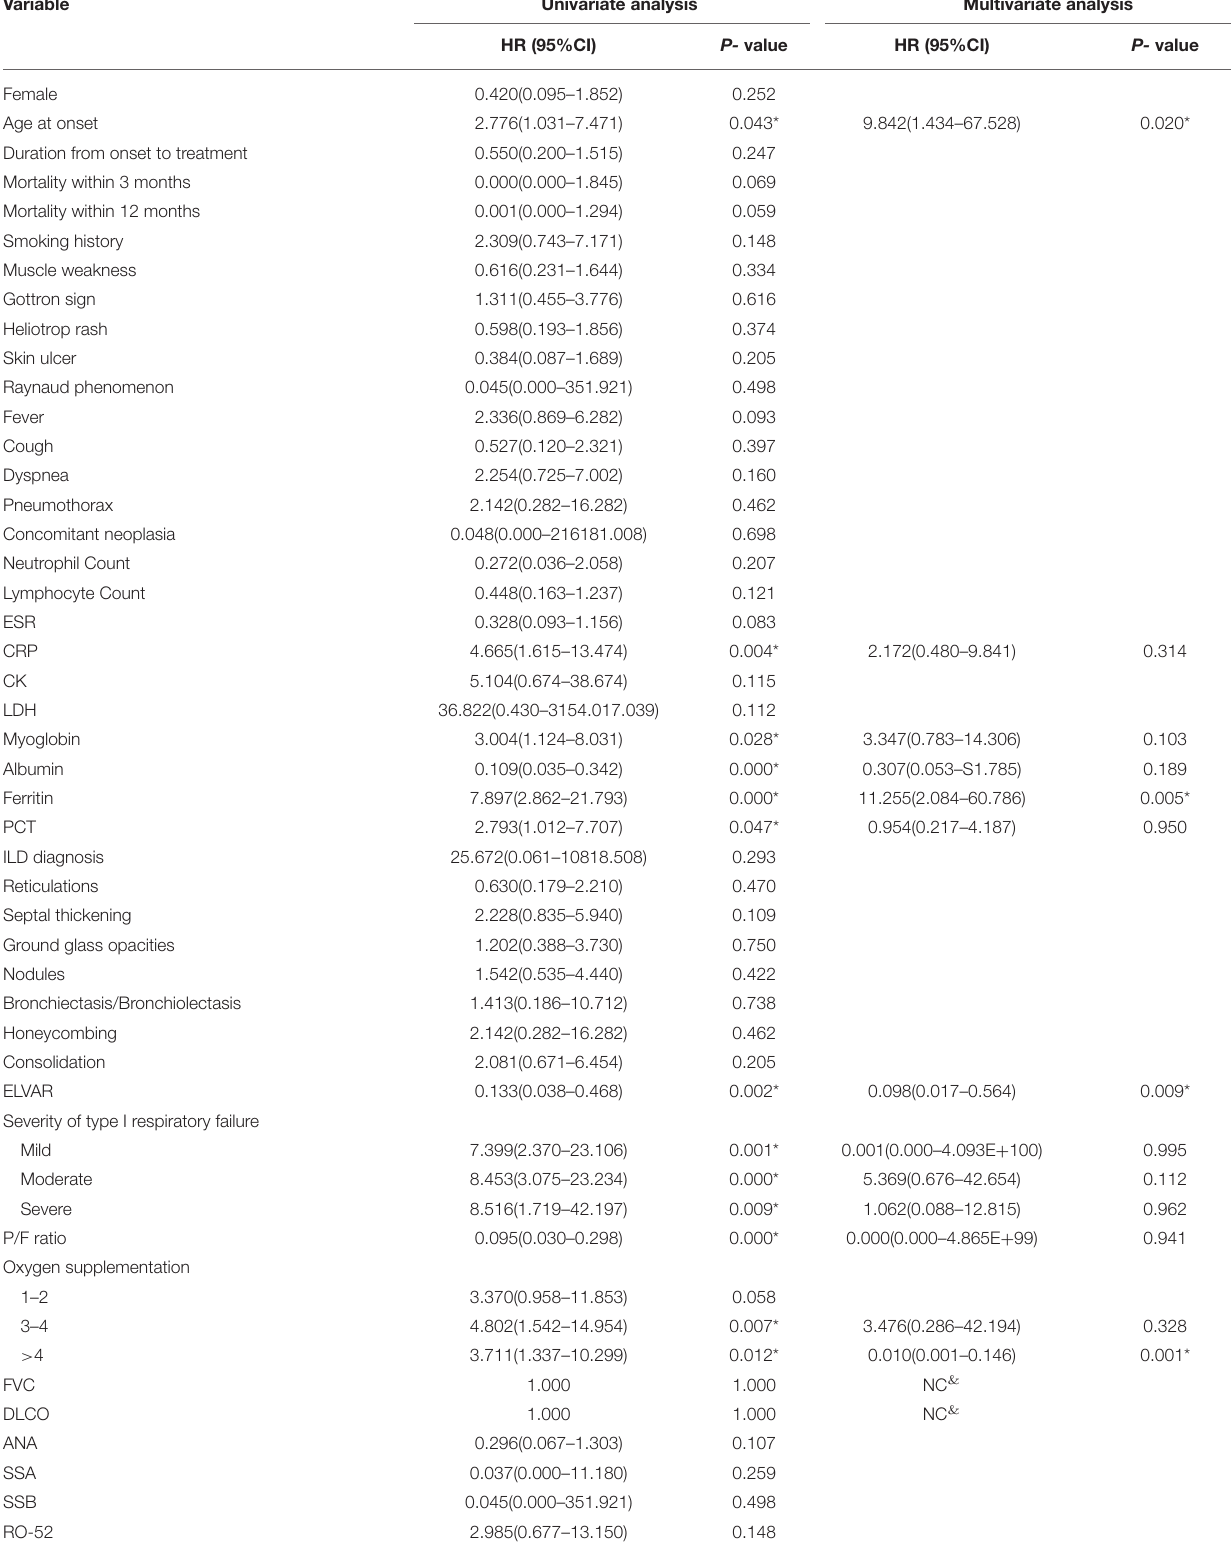
TABLE 5 | Univariate analysis and Multivariate analysis of prognostic factors in MDA5 + DM patients.